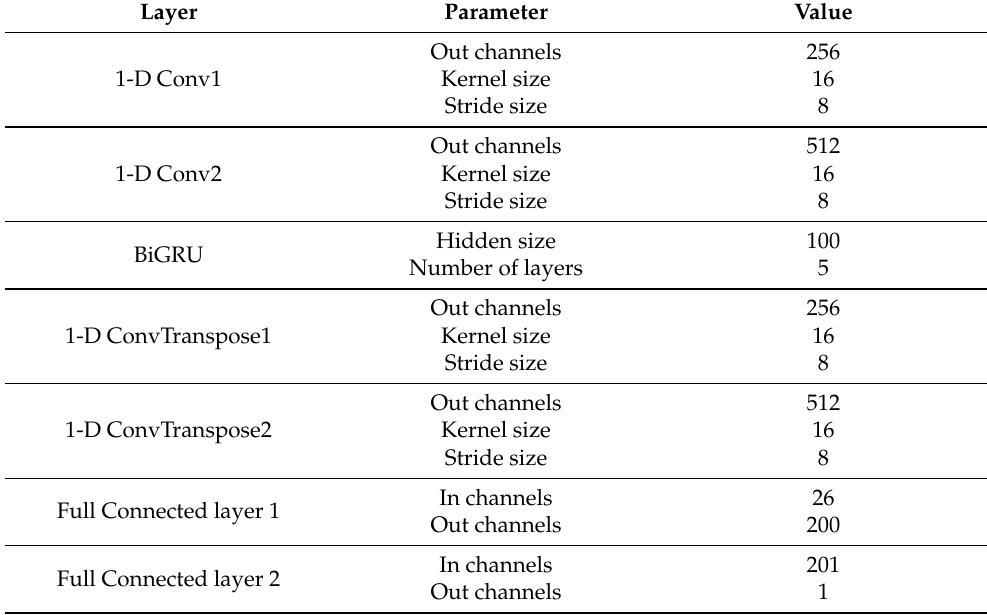
Table 2. Prediction network parameter